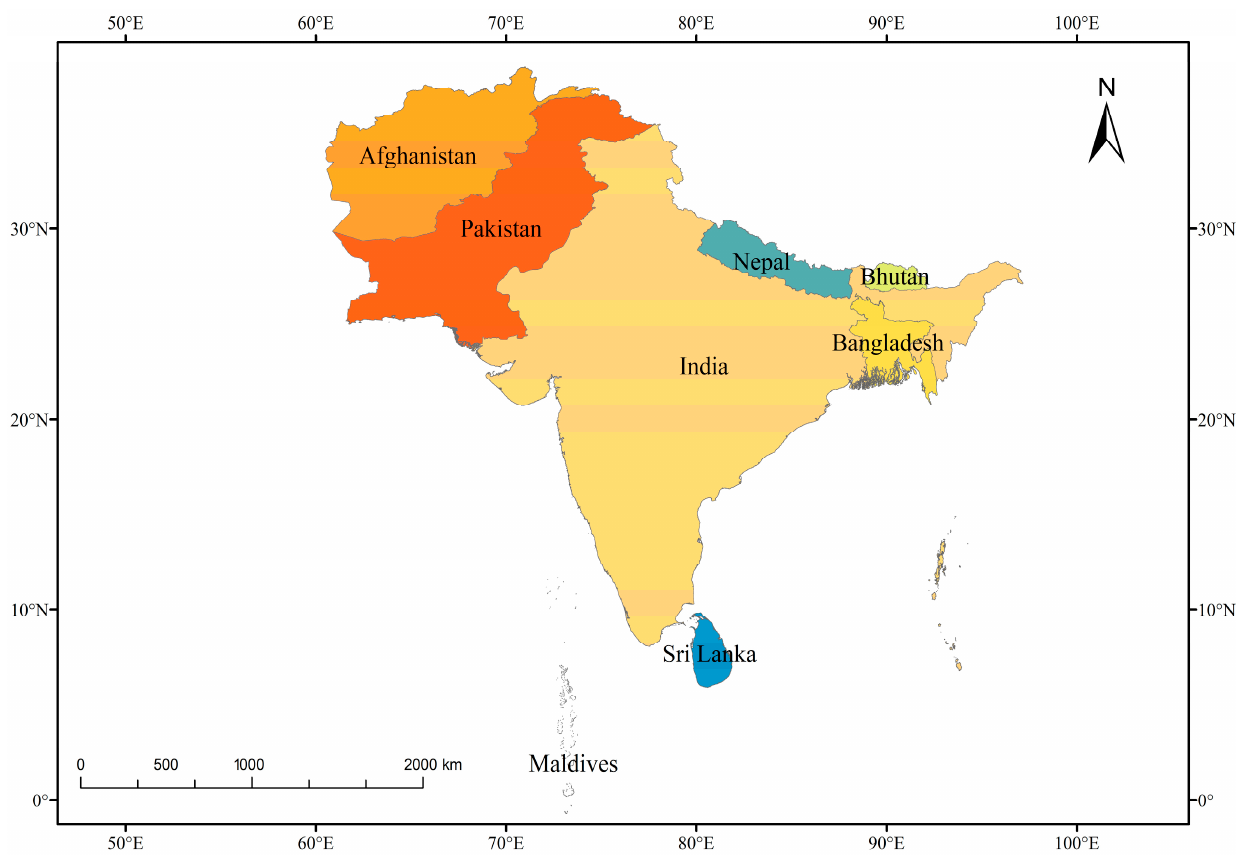
Figure 1. The countries of South Asia.